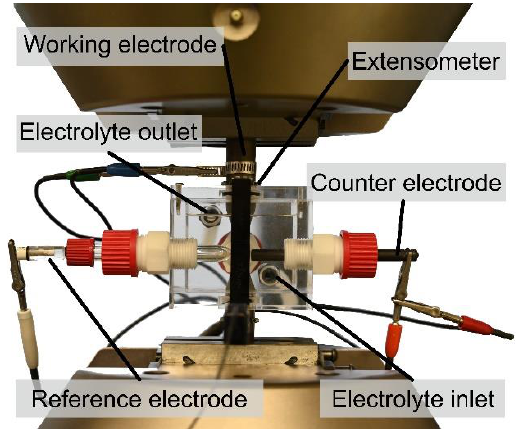
Figure 4. Experimental corrosion fatigue test setup.